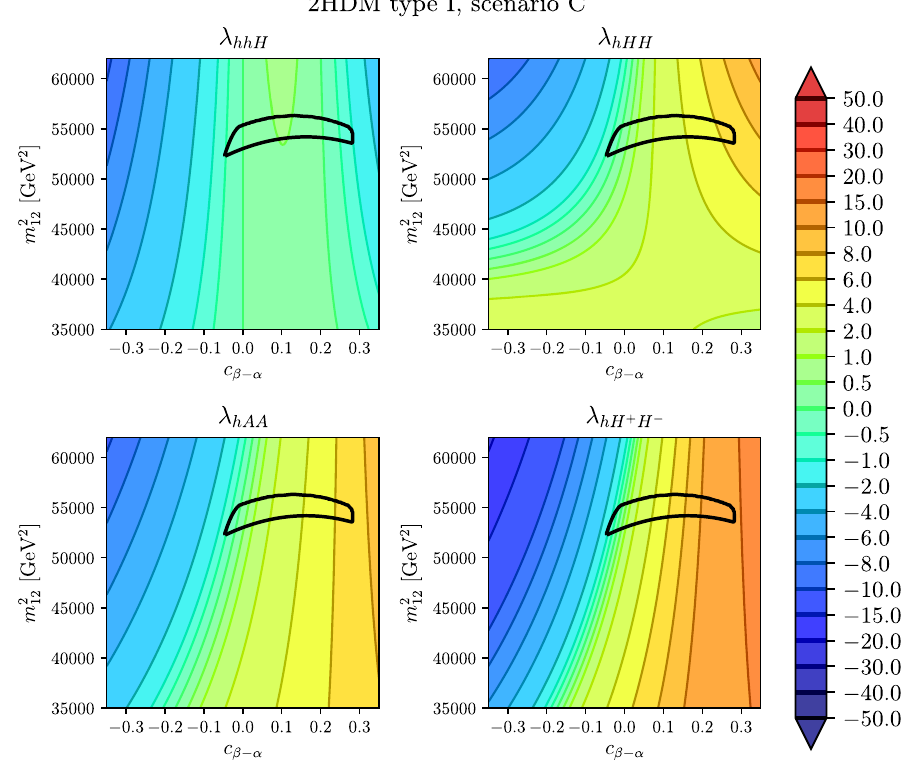
) plane for m = m = m = 650 GeV H A H ± 12